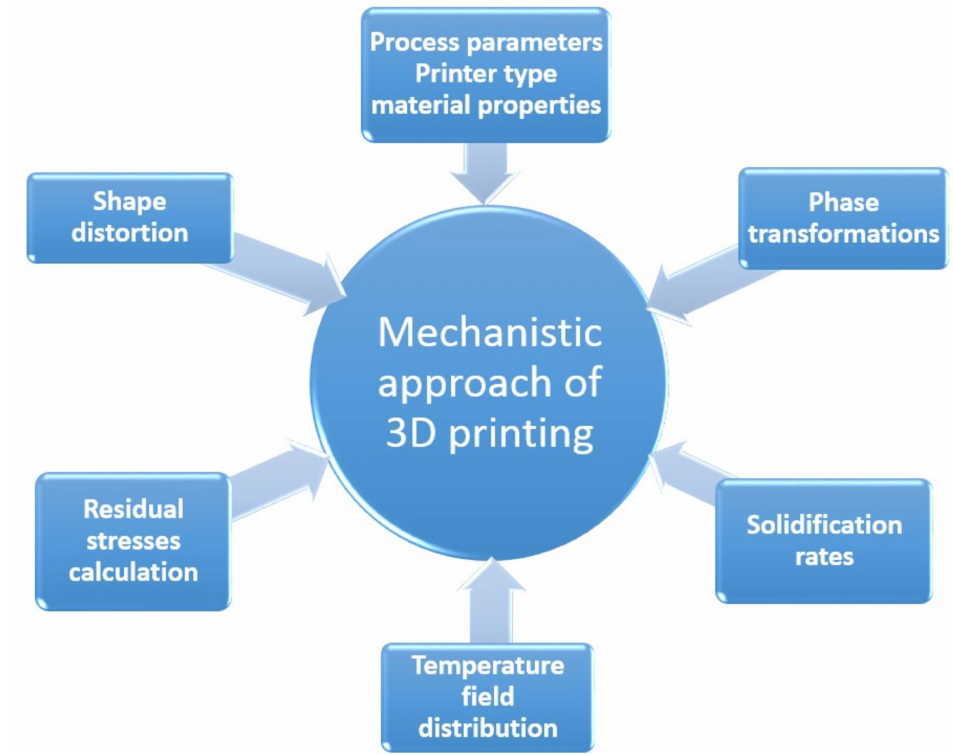
Figure 4. Forecast mechanistical approach model for 3D printing processes.